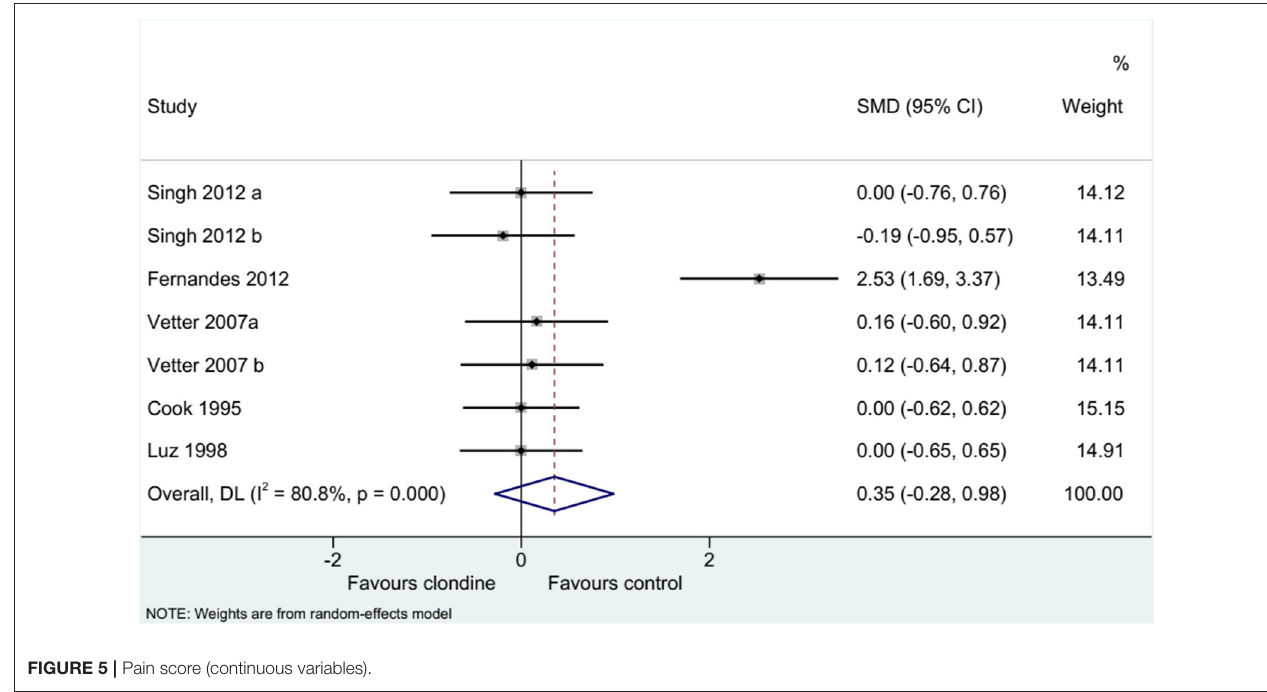
FIGURE 5 | Pain score (continuous variables).